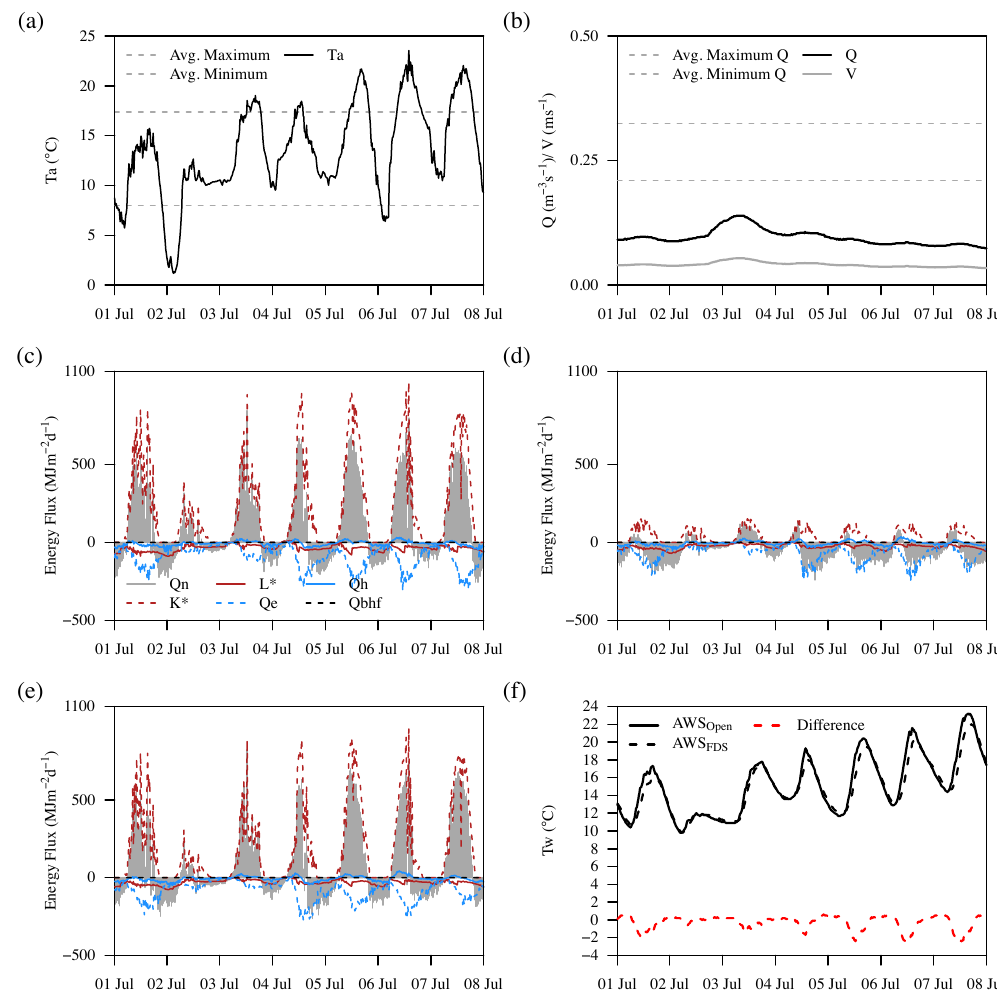
Figure 2. Study period (a) air temperature, (b) discharge and energy fluxes at (c) AWS Open , (d) AWS FUS , (e) AWS FDS and (f) water temperature at AWS Open , AWS FDS and AWS Open minus AWS FDS (positive values indicate that temperature AWS Open was greater than temperature at AWS FDS ). Averages represent values for DOYs (days of the year) 183 to 289 in the 10 years preceding